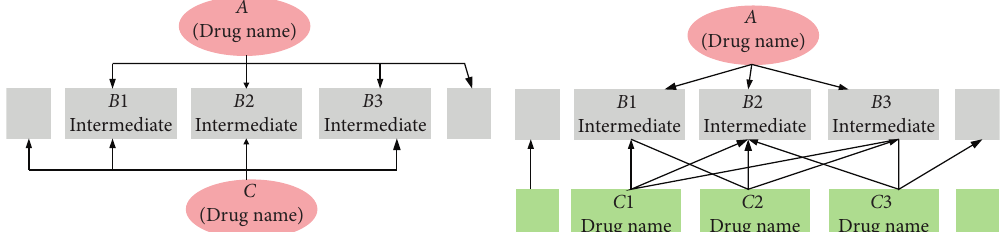
Figure 4: ABC principle of hidden associations between drug vocabularies in biomedical and pharmaceutical literature.